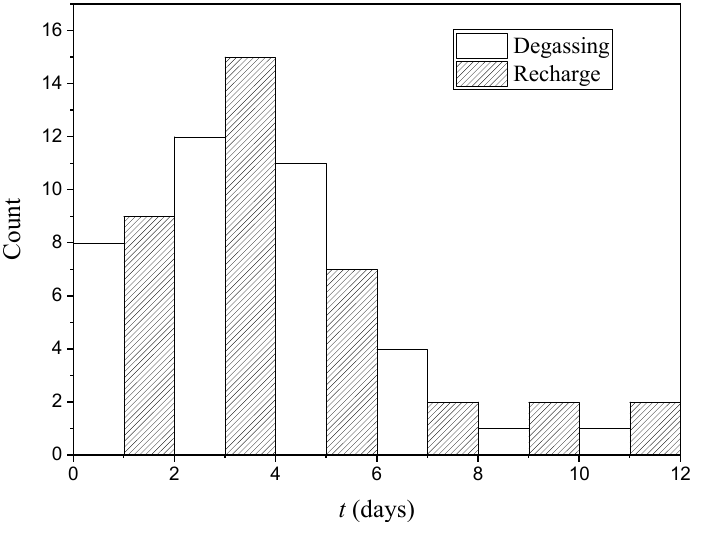
Figure 6. Distribution of duration of degassing and recharge events. Dates of every event are shown in supplementary material.